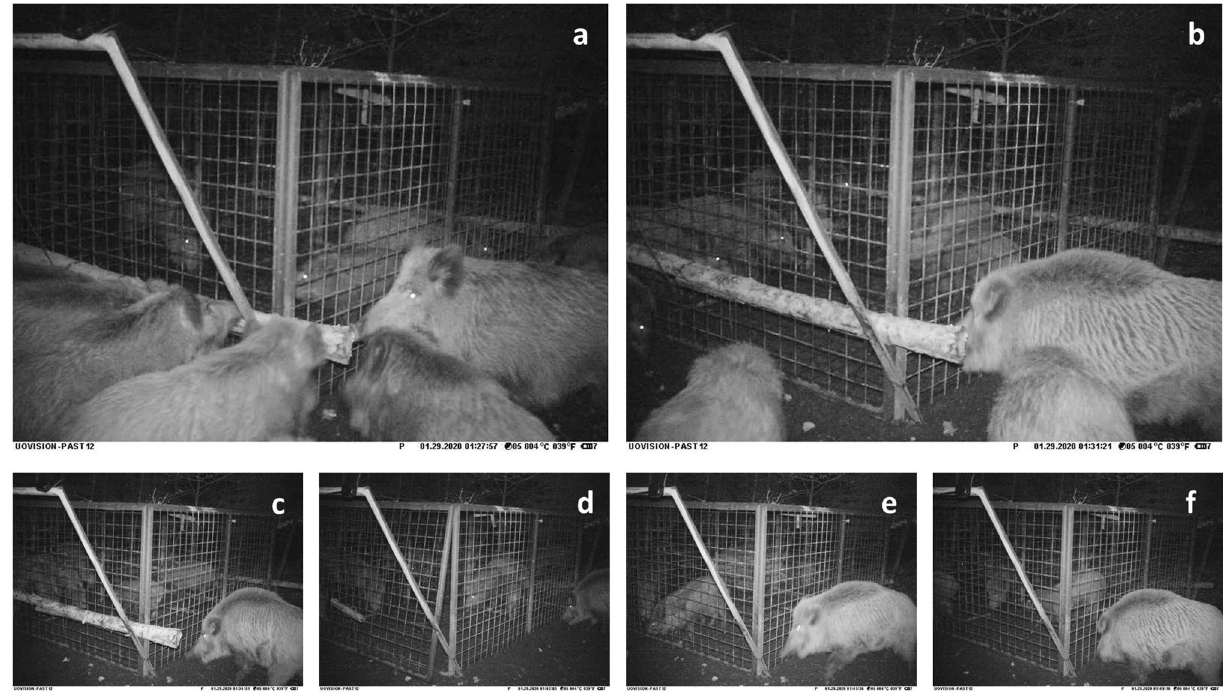
Figure 3. The piloerection of adult female wild boar during the rescue behaviour. See ( a ) and ( b – f ) for comparison of non-piloerected and piloerected